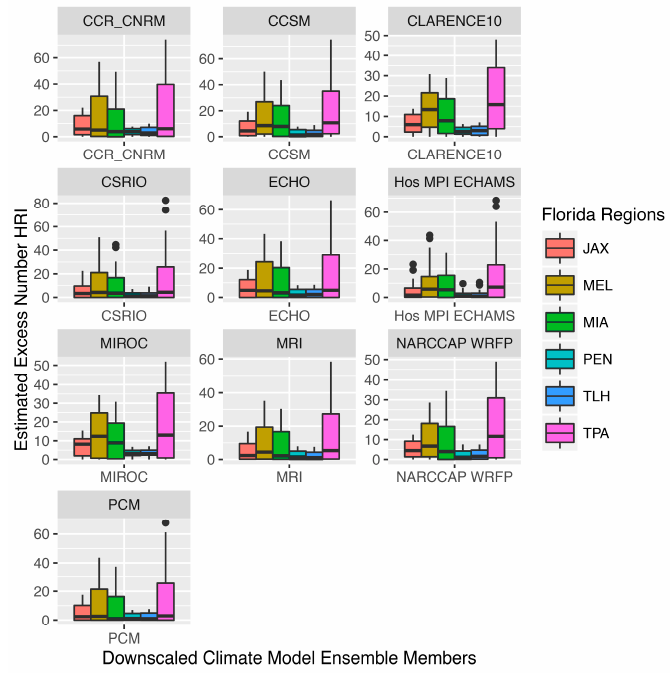
Figure 9. Estimated excess number of heat-related illness by downscaled Florida regional climate model for six Florida regions.